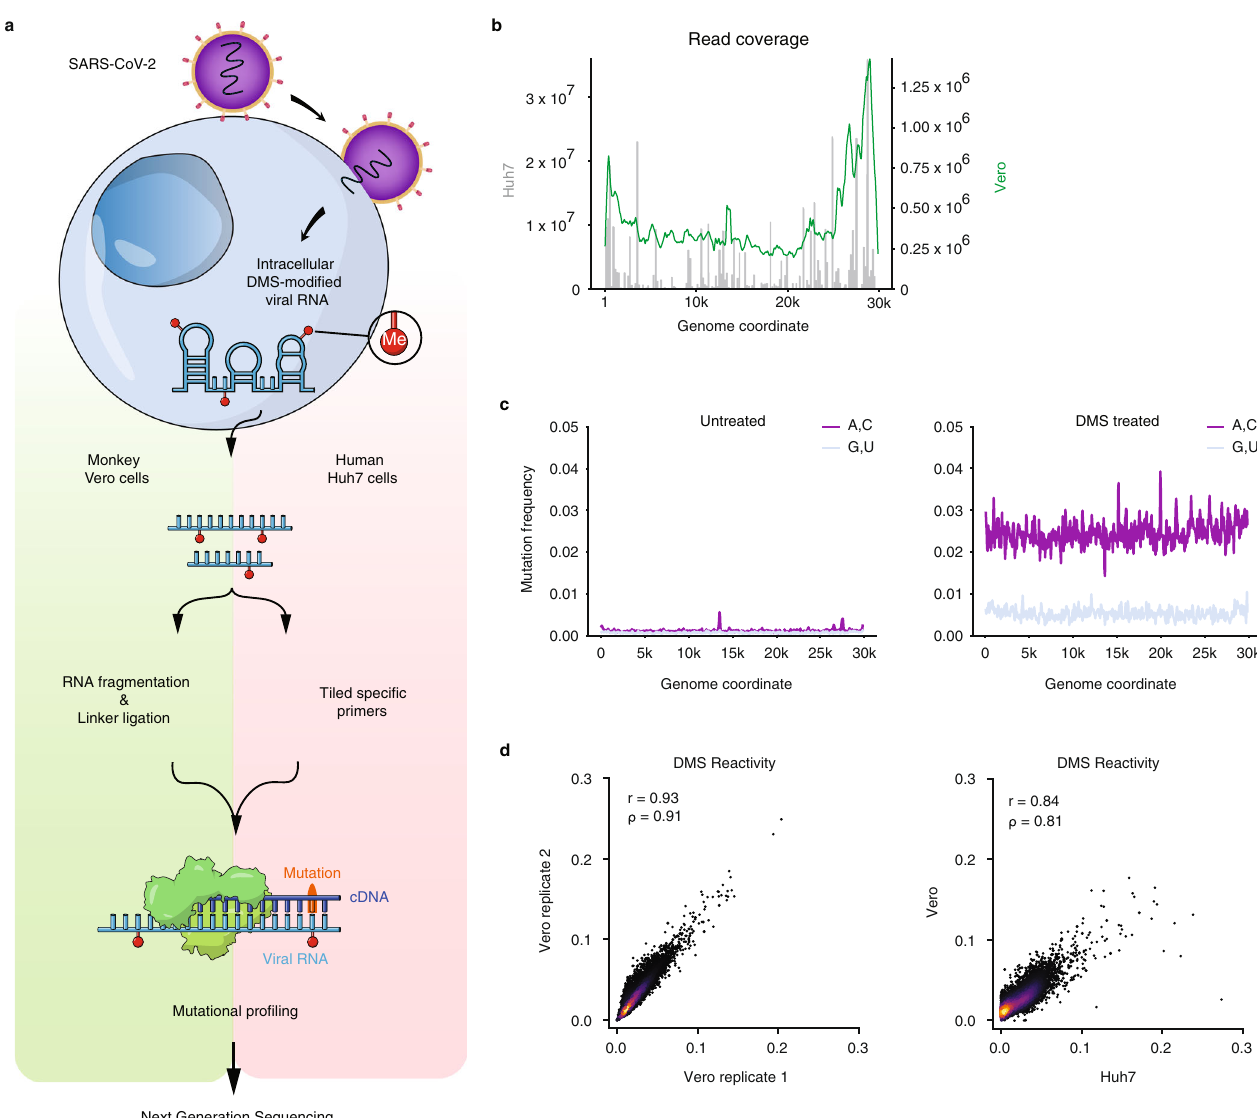
Fig. 1 Genome-wide probing of SARS-CoV-2 RNA structure in infected Vero and Huh7 cells with DMS-MaPseq. a Schematic of the experimental protocol for probing severe acute respiratory syndrome coronavirus 2 (SARS-CoV-2) RNA structures in Vero and Huh7 cells using dimethyl sulfate mutational pro fi ling with sequencing (DMS-MaPseq). b Read coverage as a function of genome coordinate for Huh7 cells using tiling speci fi c primers (gray bars, left axis) and Vero cells using linker ligation (green curve, right axis); Vero coverage was smoothed by taking the mean over a sliding window of 500 nt. c Signal vs. noise plots of mutation frequencies (i.e., among all reads aligning to each genome coordinate, the fraction of reads with a mutation at that coordinate) on adenines (As) and cytosines (Cs) vs. guanines (Gs) and uracils (Us) as a function of genome coordinate for untreated and DMS- treated RNA. A mutation frequency of 0.01 at a given position represents 1% of reads having a mismatch or deletion at that position. Signal and noise were smoothed by taking the mean over 100 nt windows in increments of 50 nt. d Comparison of DMS reactivities on As and Cs between biological replicates in Vero cells (left) and between the averaged of Vero replicates and Huh7 cells (right). Pearson ( r ) and Spearman ( ρ ) correlation coef fi cients are shown. For each sample, the top 0.05% of mutational fractions (values over 0.27 for Vero and 0.38 for Huh7) were considered outliers and excluded from the plot and calculation of correlation coef fi cients. Source data are provided as a Source Data fi